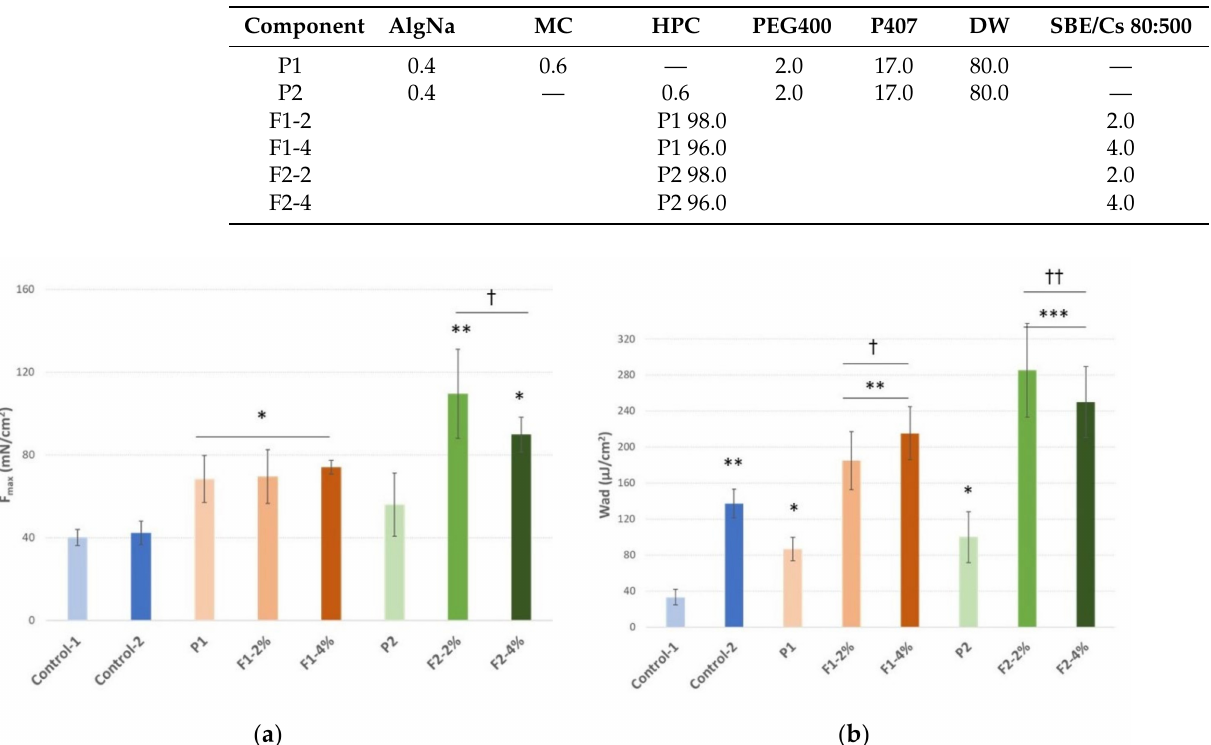
Table 4. Percent composition of the prepared formulations.